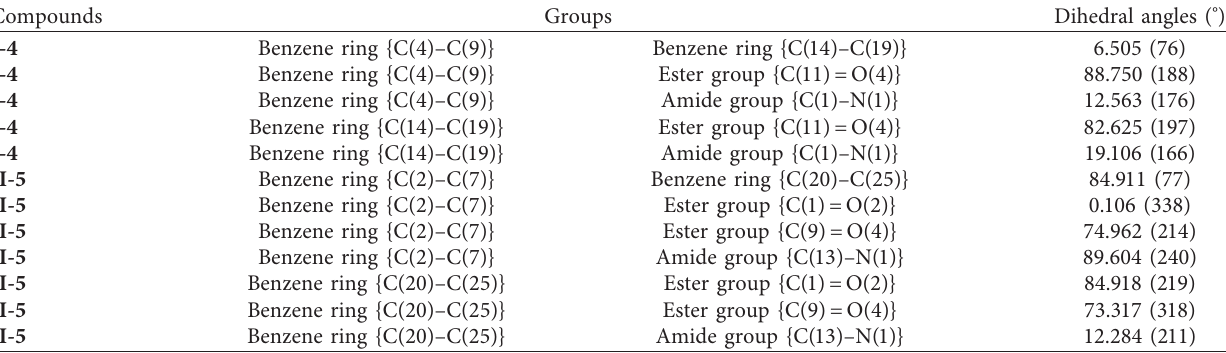
Table 2: Selected dihedral angles ( ° ) for the compounds I-4 and II-5.